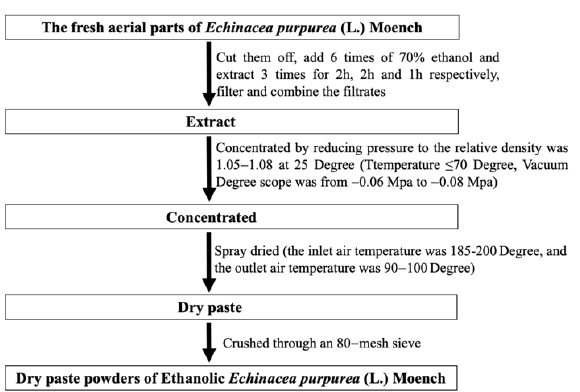
Figure 13. The flow diagram on the preparation of ethanolic Echinacea purpurea extracts.